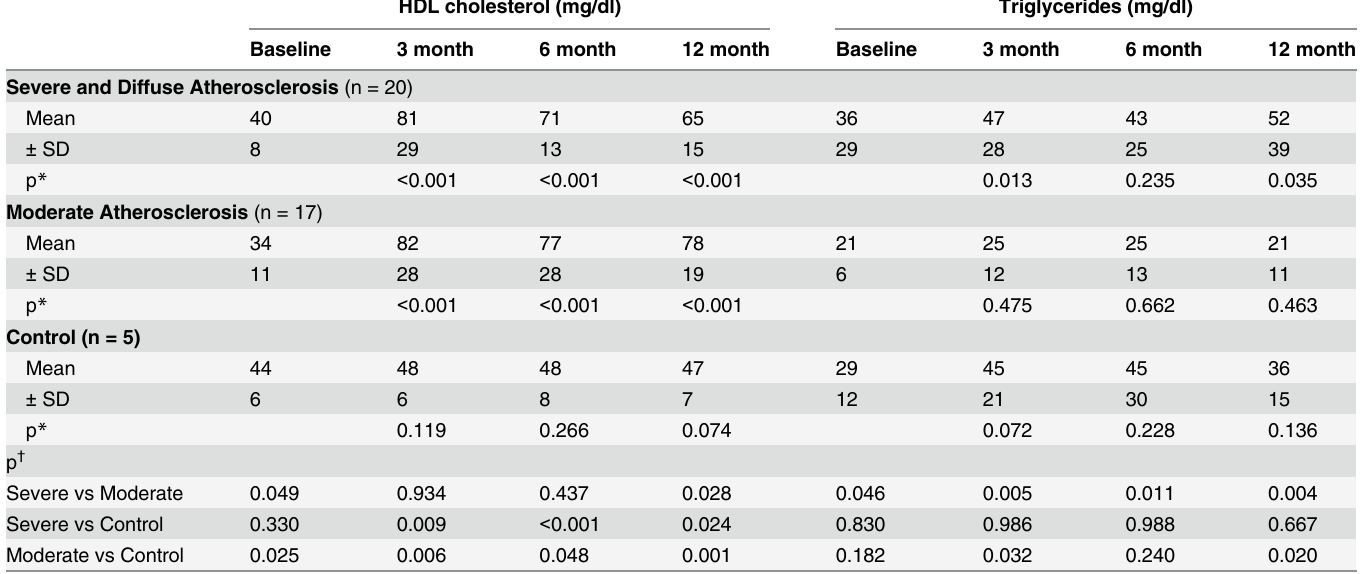
Table 7. Fasting HDL Cholesterol and